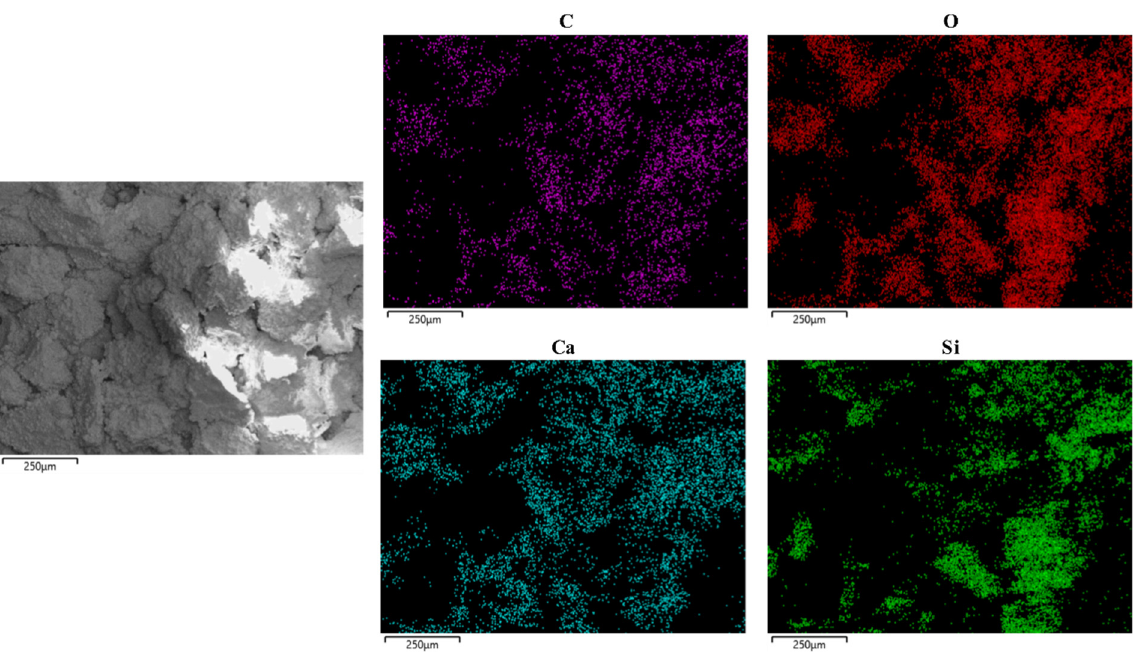
Figure 8. SEM-EDS mapping of the sand column.